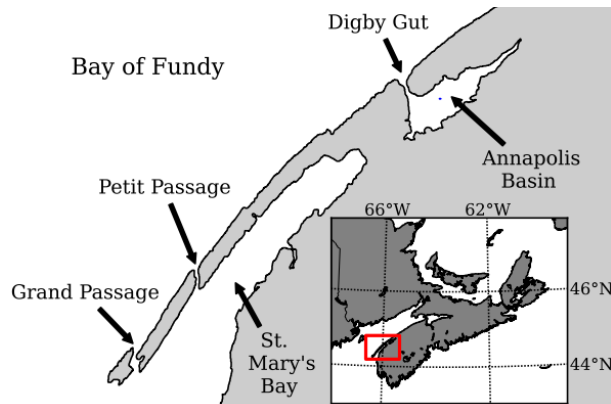
Fig. 4 Digby Neck region (Nova Scotia, Canada)